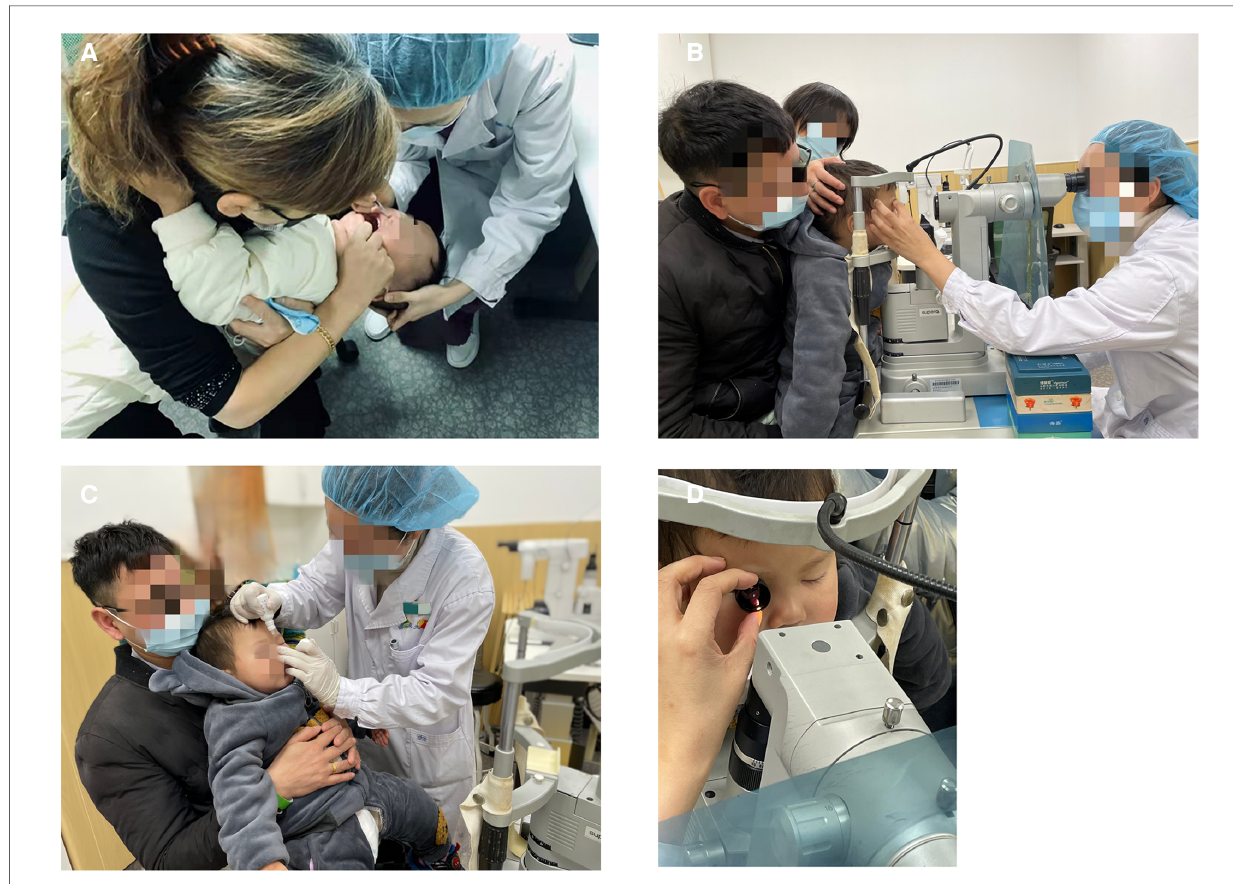
FIGURE 1 The procedure of Nd:YAG treatment under intranasal dexmedetomidine sedation. ( A ) Intranasal dexmedetomidine (3 ug/kg) sedation was administrated to the patient. ( B ) Topical anesthesia was applied to the patient. ( C,D ) The Nd:YAG laser procedure was performed with children in the sitting position with their chins supported on the laser delivery slit